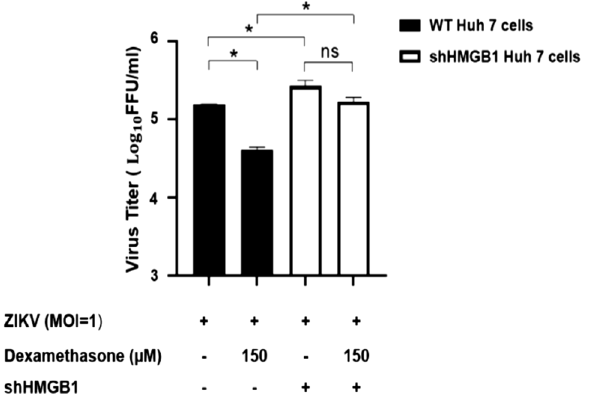
Figure 7. Role of HMGB1 in dexamethasone’s antiviral response against ZIKV. Wild-type (WT) and HMGB1- knockdown (shHMGB1) Huh7 cells were treated with 0 and 150 μM of RESV after ZIKV infection at MOI of 1. The cell supernatants were harvested at 72 h.p.i and virus titers were determined using the focus-forming assay. Asterisks (*) indicate a significant difference (P < 0.05).